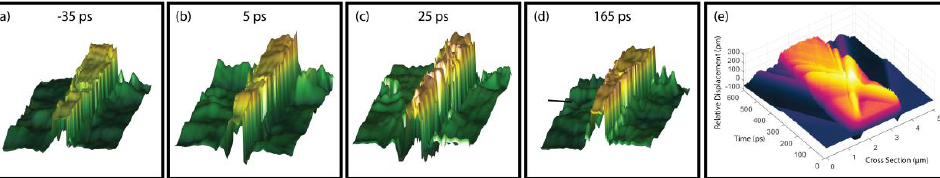
Fig. 2. (a-d) Ptychography CDI reconstructions of a subsection of the Ni triangle at different time delays. The different panel display the spatially resolved acoustic and thermal dynamics of this sample. The scale bar in (d) is 2 μ m in the lateral direction and 0.5nm in the vertical. The scale is the same in each image (a-d). (e) A simulation displaying the acoustic dynamics through a transverse slice of the